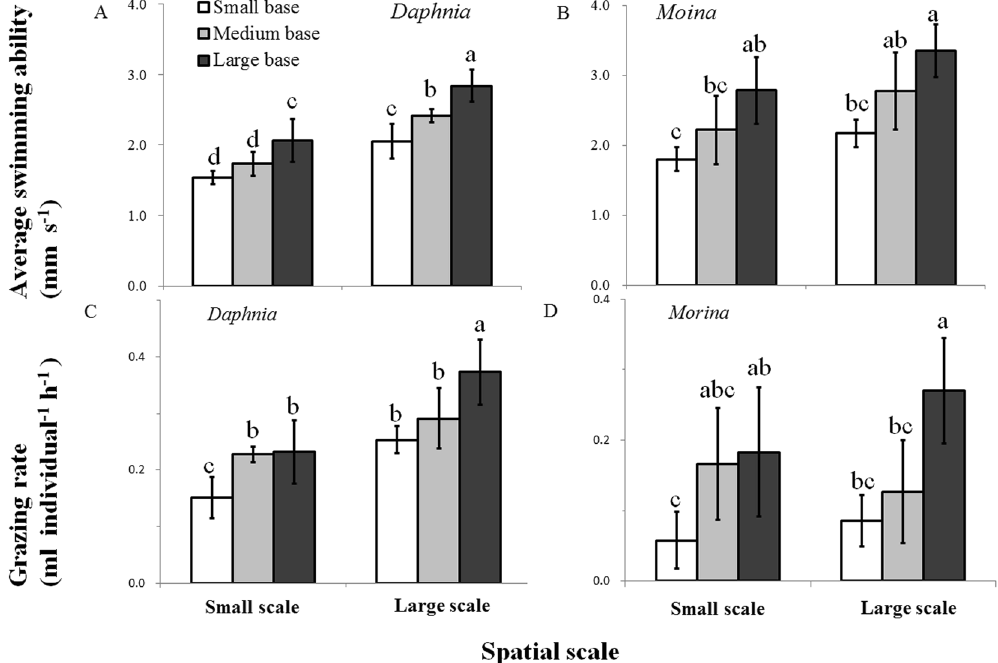
Figure 2. Average swimming ability ( A , B ) and grazing rate ( C , D ) of grazer species ( Daphnia magna and Moina micrura with the green alga Chlorella pyrenoidosa as the exclusive diet) under three levels of habitat orientation and two levels of spatial scale (means ± 1 s.d., n = 6). Different letters indicate significant differences among treatments. Multiple comparisons of means were performed using Tukey’s test at the 0.05 significance level. Figure 2 was created using Microsoft Excel